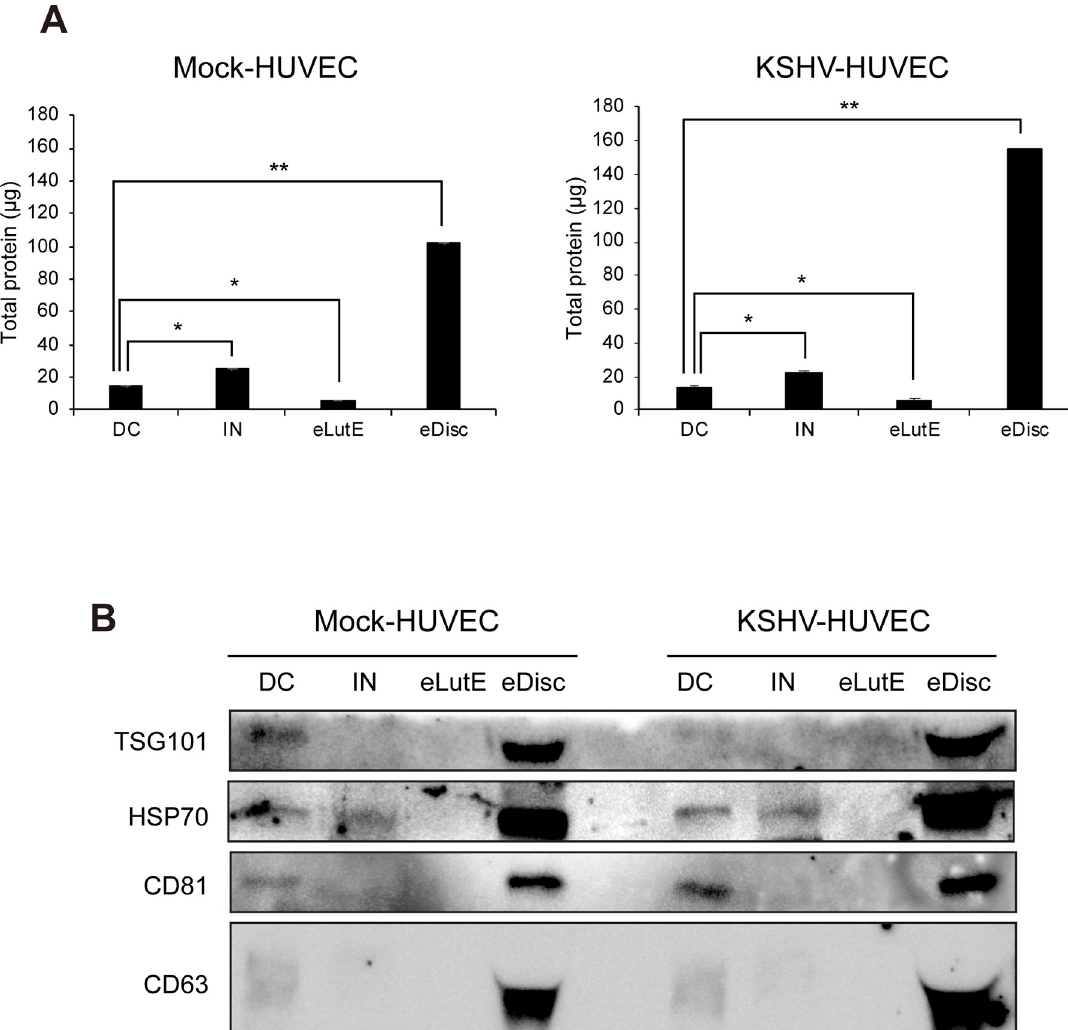
Fig 5. Analysis of proteins from EVs separated using each method. (A) Quantification of EV proteins isolated using the four different separation methods. The total quantity of proteins was calculated using BCA and is presented based on the EVs separated from 1 mL of culture supernatant. DC: EVs separated using differential centrifugation. IN: EVs separated using the Invitrogen Total Exosome Isolation reagent. eLutE: EVs separated using the ExoLutE exosome isolation kit. eDisc: EVs separated using Exodisc from LabSpinner. Data are shown as the mean ± SD, n = 3, � p < 0.05, �� p < 0.01. (B) Western blot analysis of EV markers. Equal volumes of EVs separated by each method were loaded onto the gel, and EV markers were analyzed by western blotting. Mock-HUVEC: mock-infected HUVECs. KSHV-HUVEC: KSHV-infected